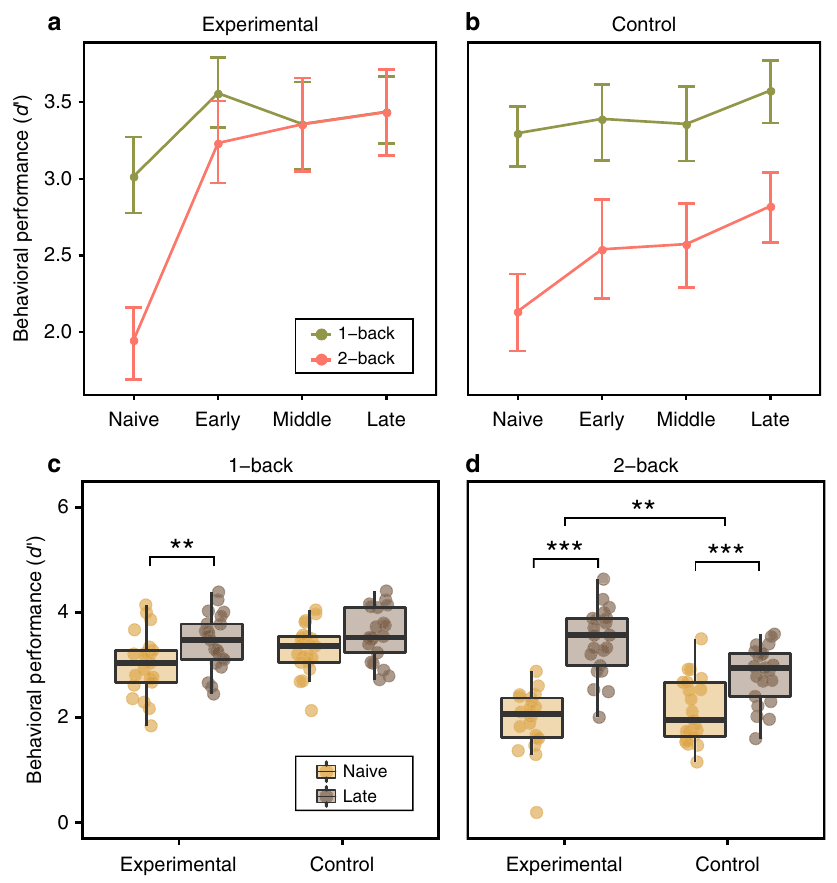
Fig. 2 Behavioral performance modulated by training. a , b Line plots representing mean behavioral performance measured as d 0 ,calculated for all training phases (Naive, Early, Middle, and Late), dual n-back conditions (1-back and 2-back), and groups ( a experimental, n = 21, and b control, n = 21). We found a signi fi cant interaction effect between the session, condition, and group. After training, the experimental group exhibited no difference in behavioral performance between the 1-back and 2-back conditions. Dots represent mean values; error bars represent 95% con fi dence intervals. c No signi fi cant difference between groups was found for d 0 reduction (from Naive to Late sessions) during the 1-back task condition. d The experimental group showed a signi fi cant reduction in d 0 compared with the control group during the challenging 2-back condition (two-sample t test, two-sided; p = 0.004). Boxes represent the interquartile range (IR) between 25th and 75th percentiles. The thick line in the center of each box represents the median. The upper and lower error bars display the largest and smallest values within 1.5 times IR above 75th percentile and below 25th percentile, respectively. *** p < 0.001 Bonferroni-corrected; ** p < 0.05 Bonferroni-corrected. Source data are provided as a Source Data fi